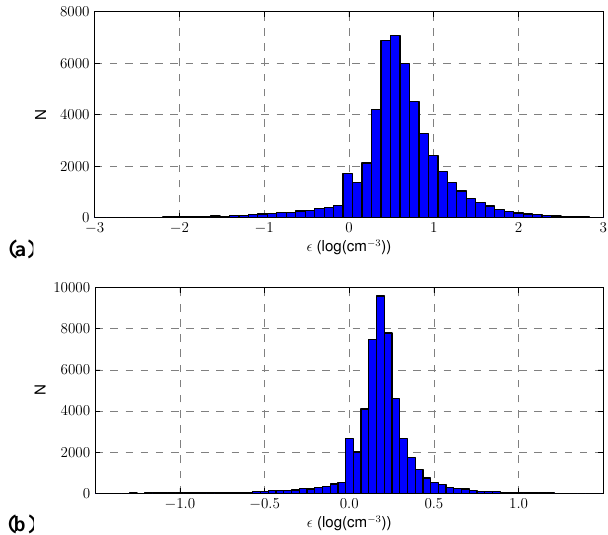
Fig. 6. Histograms of the approximation errors (cid:15)( x ) . N denotes the number of samples. (a) Approximate parameterization with 4 size sections for the aerosol particle size distributions. (b) Approximate parameterization with 7 size sections for the aerosol particle size